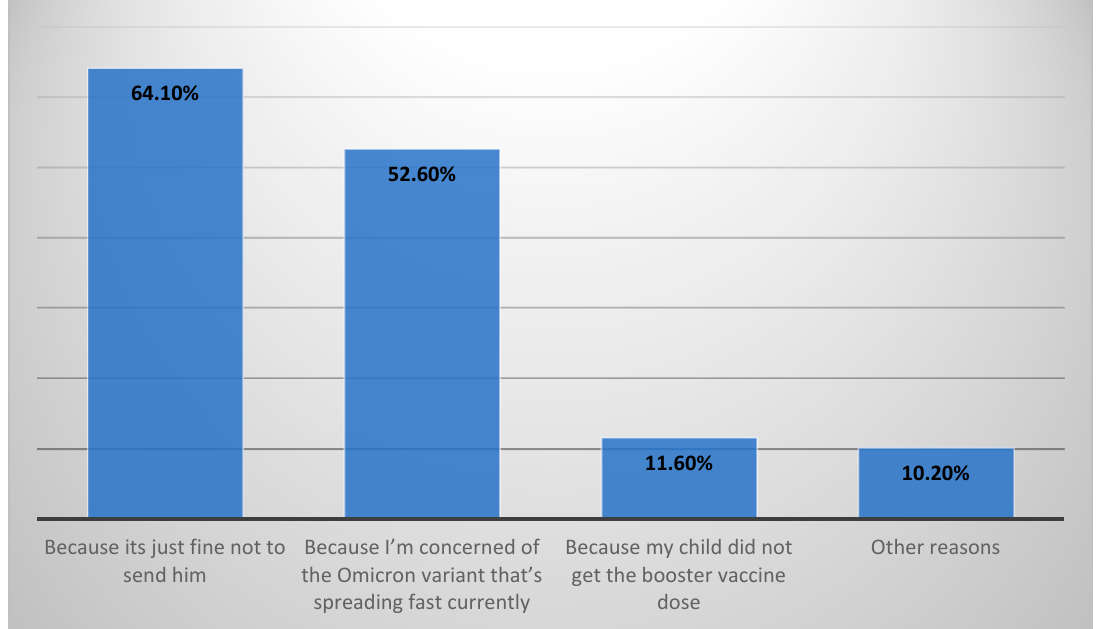
Figure A3. Parents’ reasoning of sending their teenager to school if COVID case reported in other classes.